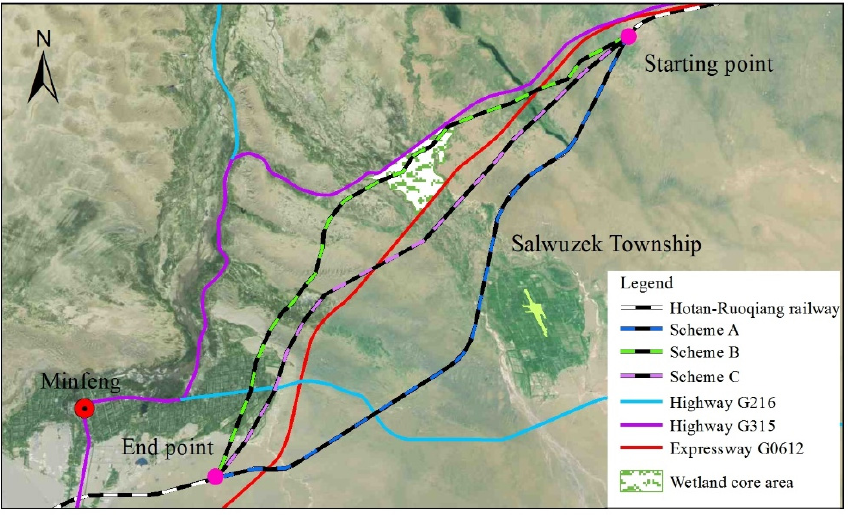
Figure 3. Schematic representation of the railway scheme.